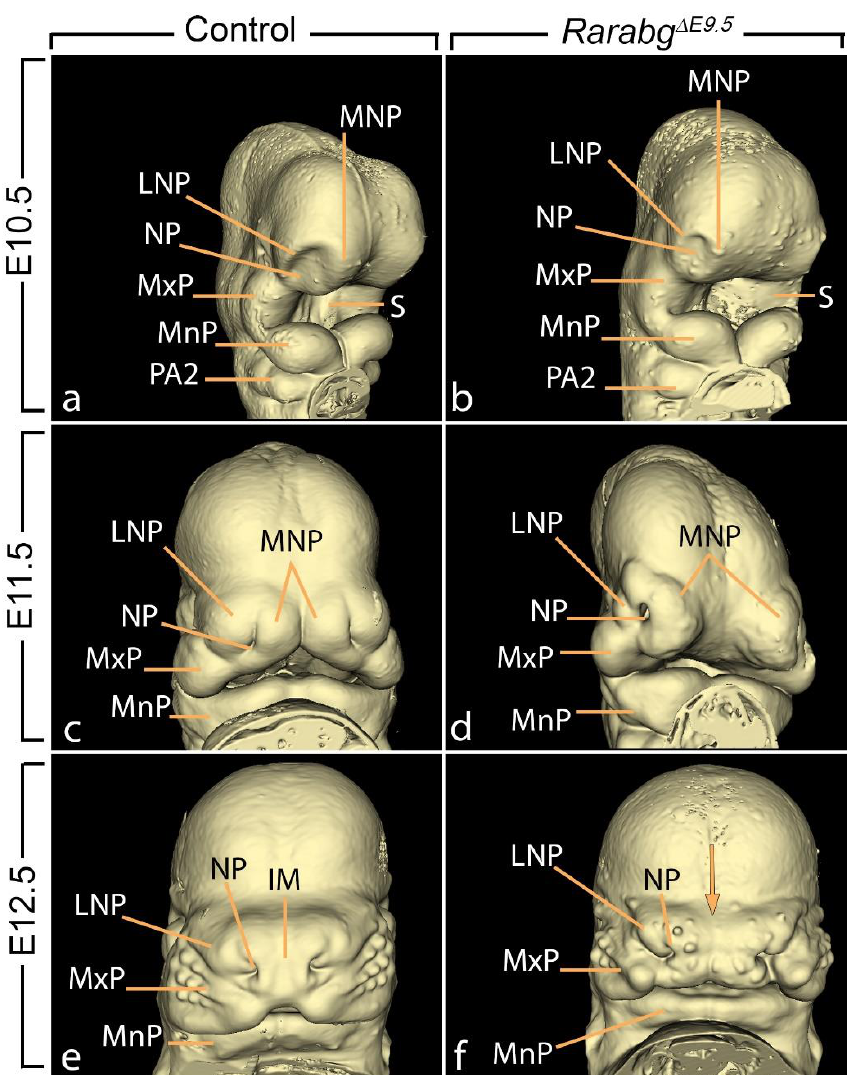
Figure 6. Facial aspect of control embryos ( a , c , e ) and Rarabg ΔE9.5 mutant littermates ( b , d , f ) at E10.5, E11.5, and E12.5, as indicated. IM, intermaxillary segment; LNP and MNP, lateral and medial nasal processes, respectively; MxP and MnP, maxillary and mandibular processes of the 1st pharyngeal arch, respectively; NP, nasal pit; PA2, second pharyngeal arch; S, stomodeum (primitive mouth). The arrow (in f) points to the midfacial cleft. Same magnifications in ( a , b ), in ( c , d ) and in ( e , f ). Rarabg ΔE10.5 mutants at E11.5 and E12.5 were undistinguishable from age-matched ∆ E9.5 In Rarabg mutants at E10.5, the lateral and medial nasal processes were markedly hypoplastic and the nasal pits faced laterally, whereas in the control embryos, they were oriented medially (compare Figure 6a,b). At E11.5, the edges of medial nasal processes